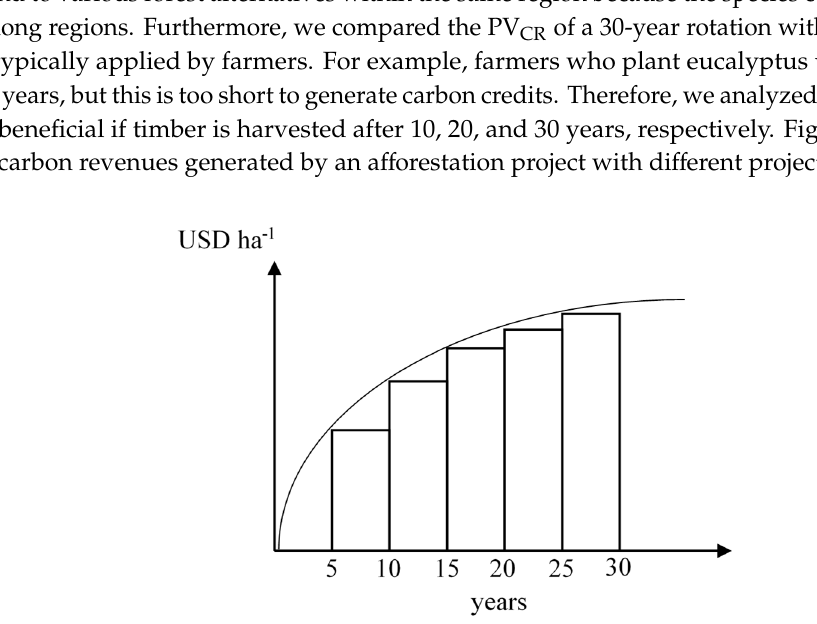
Figure 2. Revenues of carbon sequestration (USD ha − 1 ) by an a ff orestation project with di ff erent project durations.